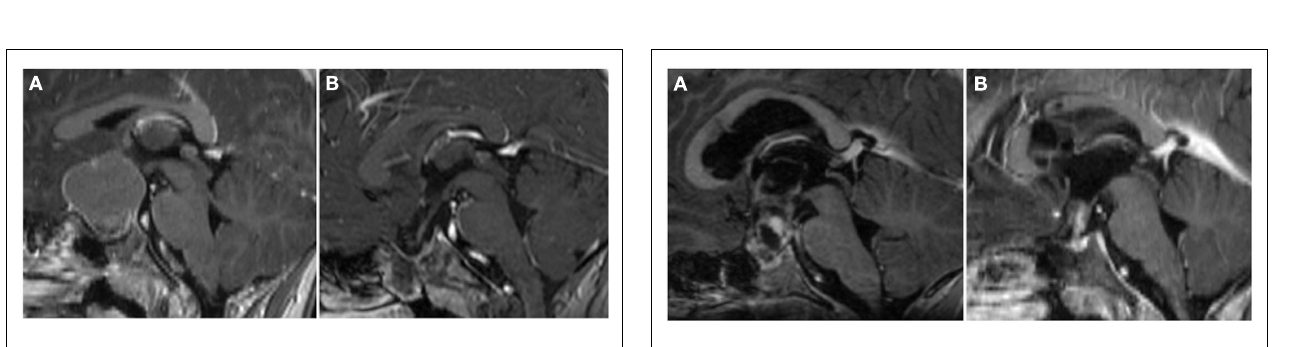
FIGURE 3 | Surgical strategy grade 0/1 pre-op. (A) On the pre-operative MRI, the hypothalamus appeared to be more displaced than invaded by tumor (Type 1 pre-op). (B) This was confirmed during surgery and a complete removal preserving the hypothalamus could be achieved (Type 0 post-op).